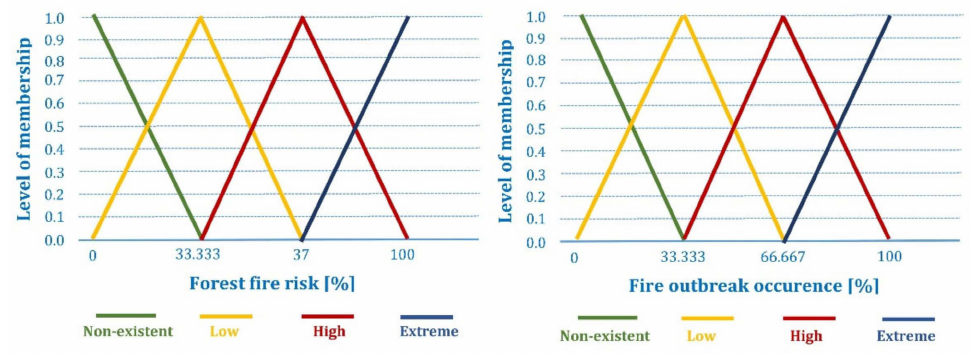
Figure 4. Membership functions of output variables, adopted from